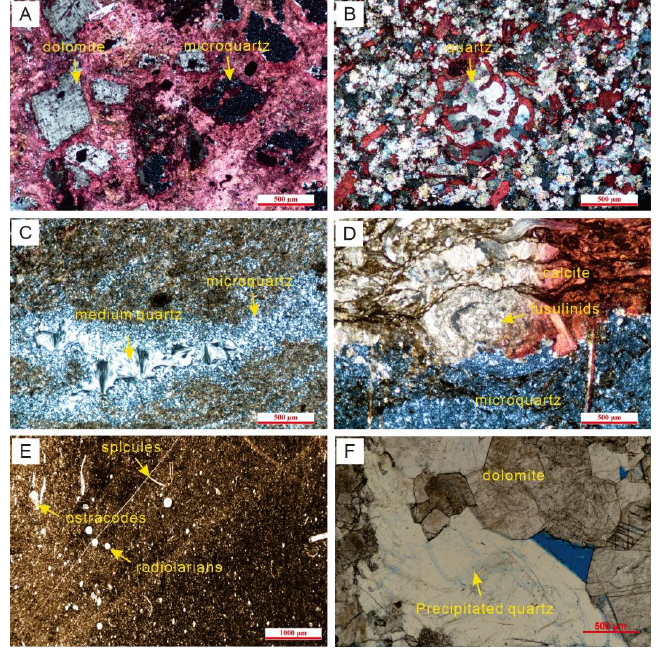
Figure 4. Microscope photos show the characteristics of the Maokou cherts. ( A ) Dolomites in the silicified limestone, MEY section; ( B ) bioclasts are silicified into fine to medium crystalline quartz in the host limestone, MEY section; ( C ) silica recrystallization is found in microfracture, MEY section; ( D ) boundary between chert and host limestone, fusulinids and other bioclasts were partially silicified into microquartz, MEY section; ( E ) bedded chert contains a large number of siliceous organisms, including spicules, ostracodes and radiolarians, SH section; ( F ) precipitated quartz appears in the intergranular pores of dolomites, XJG section.